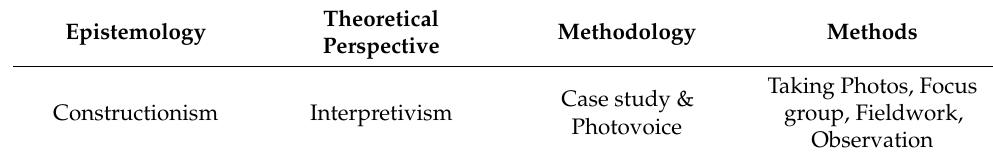
Figure 1. A study Flow Chart. Table 1. The philosophical background of this